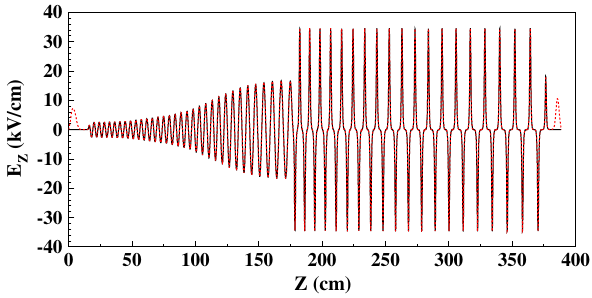
FIG. 14. Longitudinal field along the center of the RFQ before (solid black) and after (dashed red) including the field compo- nent in the gap between the flanges and the vanes.